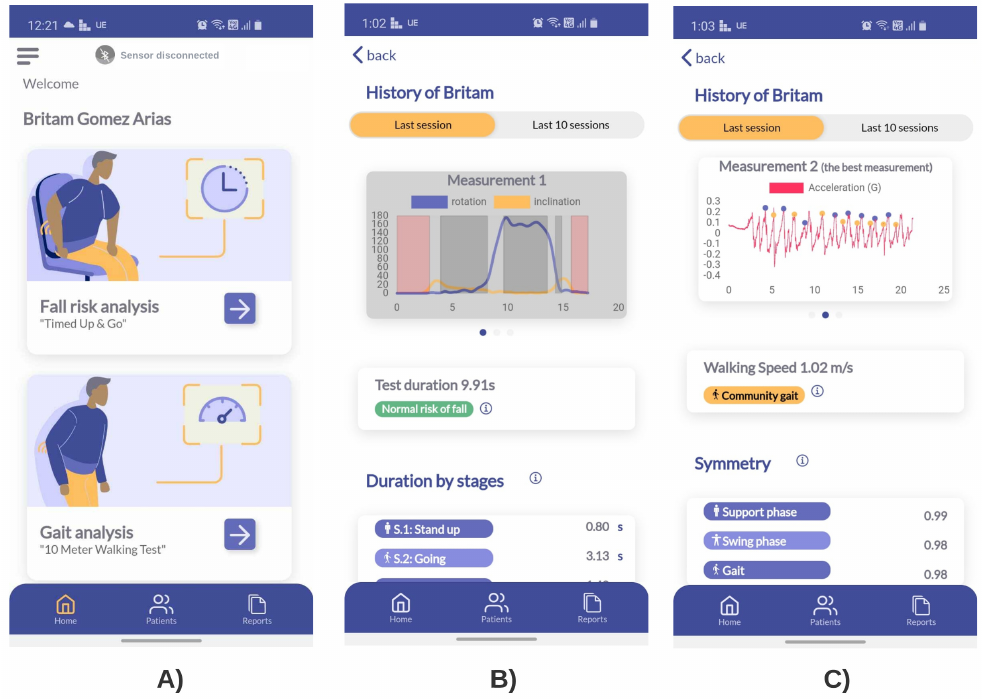
Figure 4. Mobile app implemented for home-care human movement analysis. Note that there are both tests for risk of falls and gait analysis. ( A ) Home menu to select the assessment test. ( B ) iTUG automatic results. ( C ) iT10M automatic